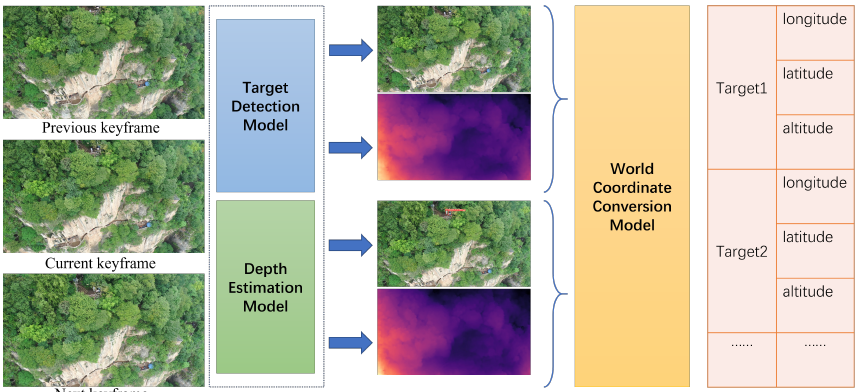
Figure 1. The target detection model detects the current frame and outputs the pixel coordinates of targets. The depth estimation model in parallel with it uses the previous frame to perform depth estimation with the current frame and obtains the absolute depth based on the displacement information of UAV. Finally the coordinate conversion model combines the pixel coordinates with the depth information to obtain the global coordinate positioning of all